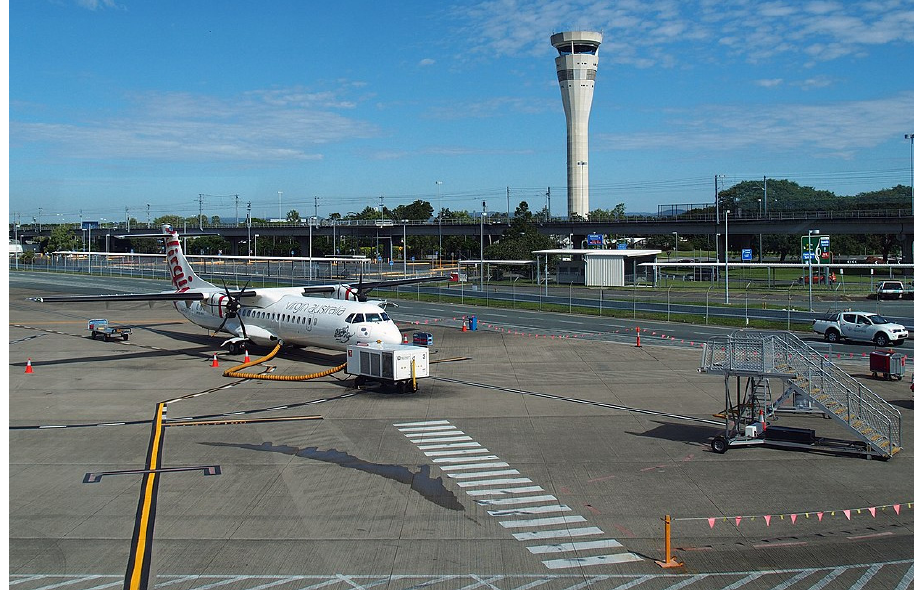
Figure 18. Brisbane West Wellcamp Airport: The largest civil project based on geopolymer concrete.